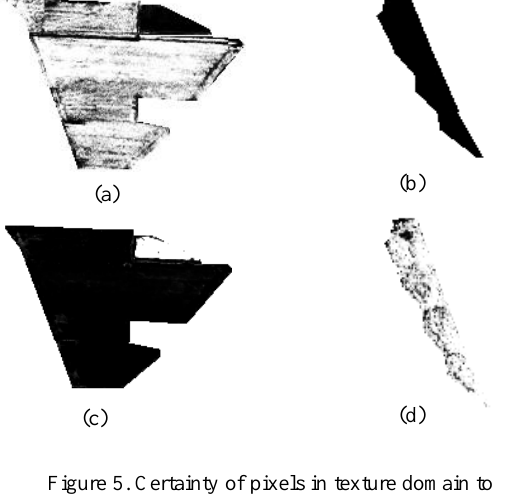
Figure 6. Certainty of pixels in indices domain to class A ((a) and (b)) and class B ((c) and (d)). Values ranges from uncertainty (0, black) to certain (1,